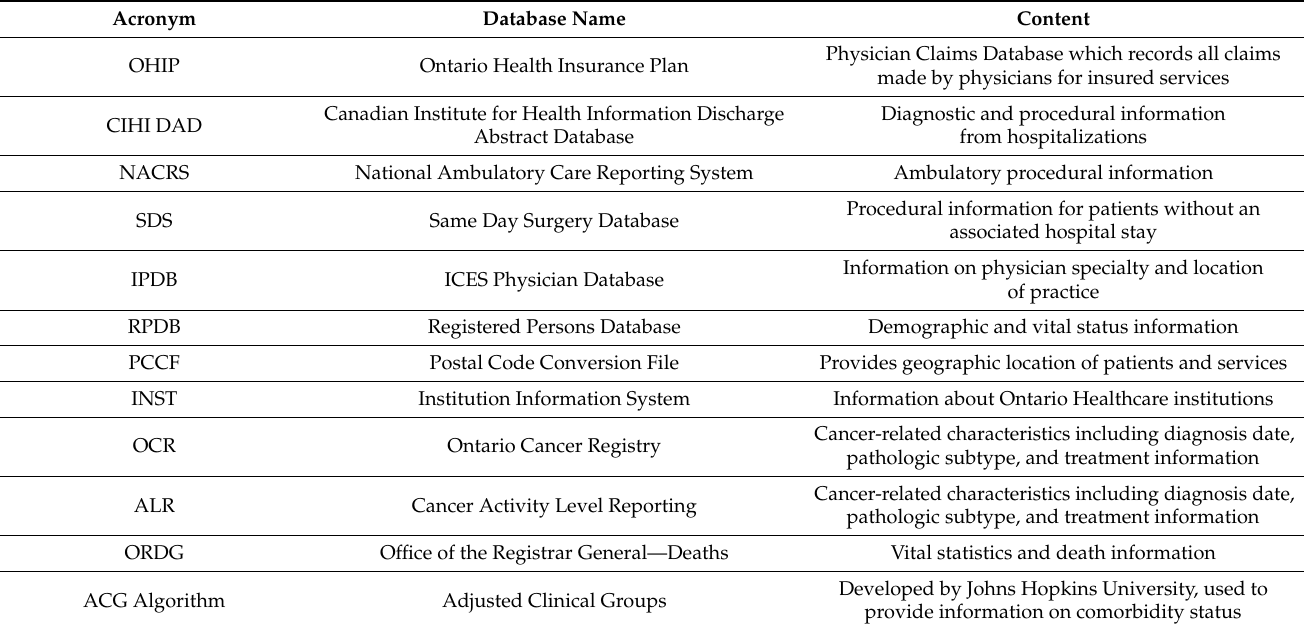
Table 1. ICES databases used for cohort creation and data